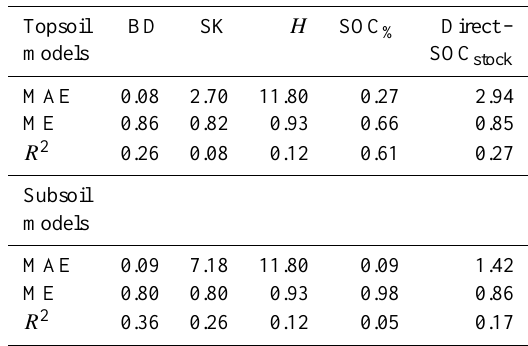
Table 5. Cross-validation performance for the respective models. Note that although the R 2 was severely reduced for most models, the MAE was generally only increased a small